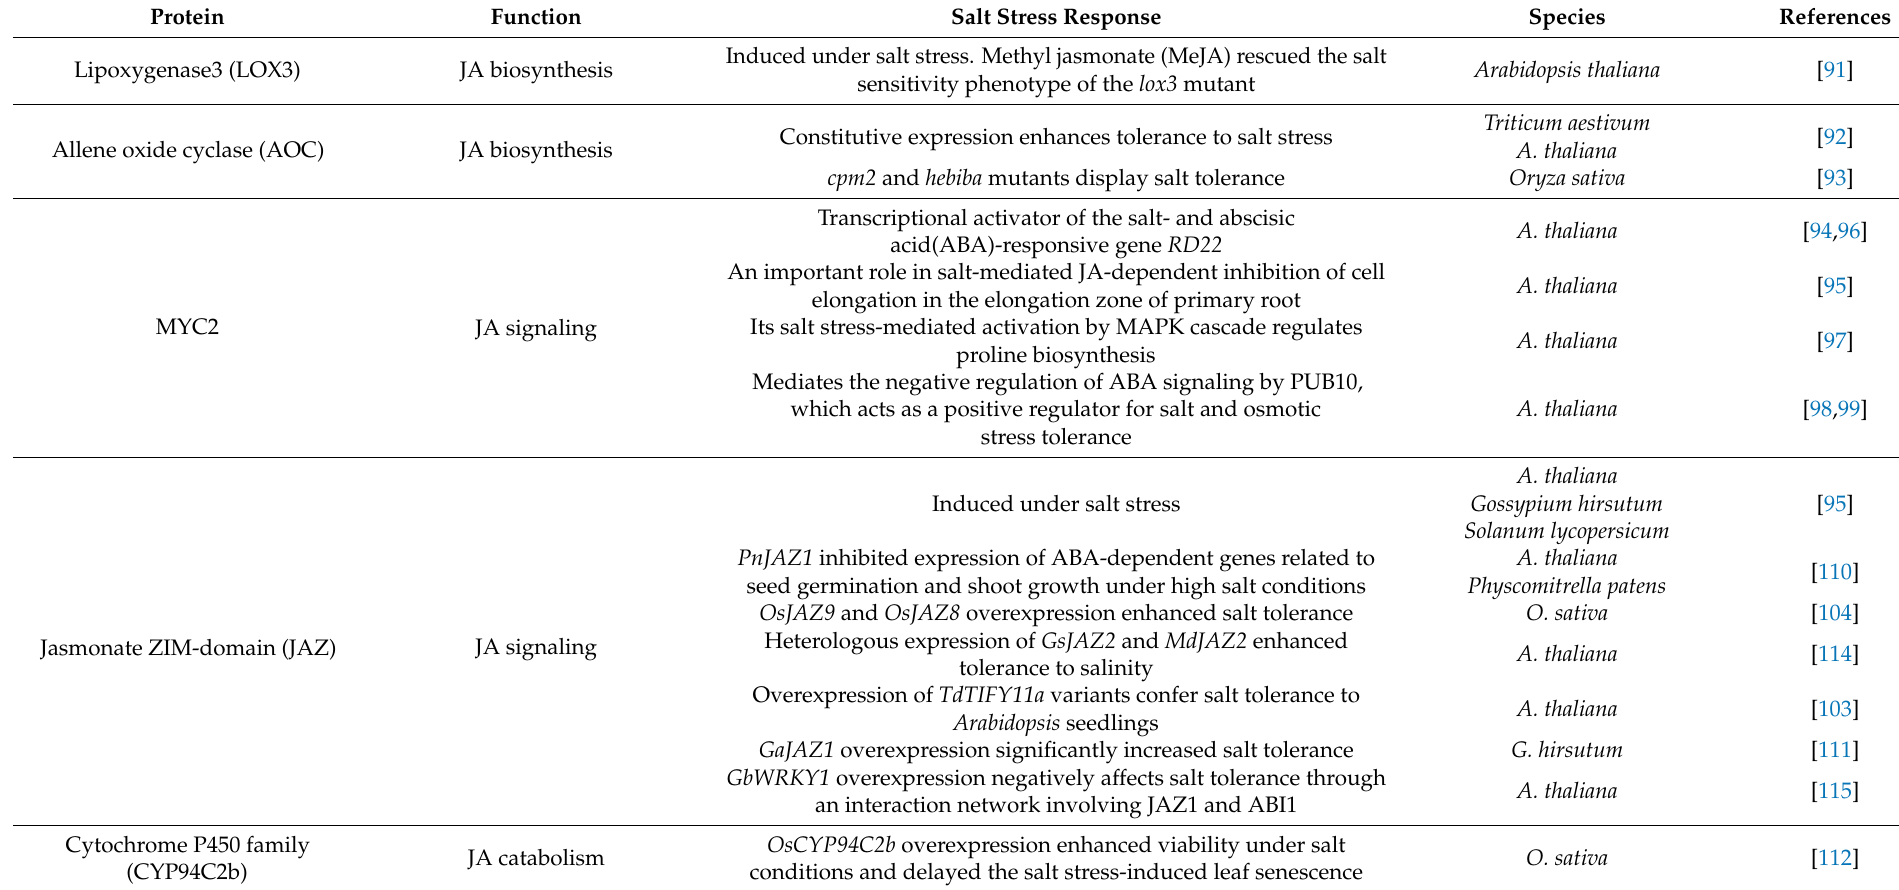
Table 1. Participation of jasmonate (JA) pathway-associated molecular components in salt stress responses of different